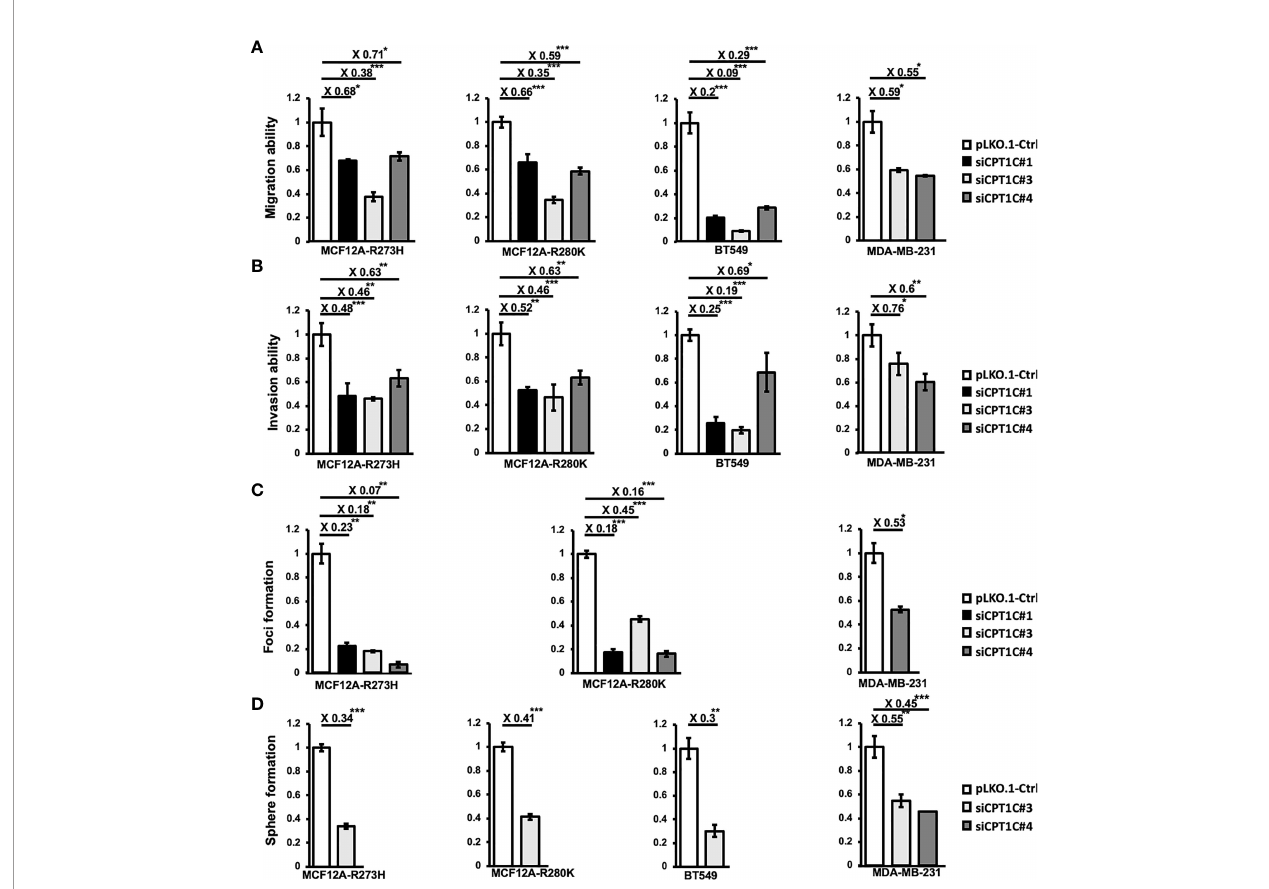
FIGURE 4 | Interference of CPT1C expression attenuates mutant p53-mediated biological effects. CPT1C expression was downregulated by RNA interference in mutant p53-overexpressing cells (MCF12A-p53 R273H and MCF12A-p53 R280K ) and BLBC cell lines (BT549 and MDA-MB-231), and these cell lines were then subjected to the following analysis. (A, B) Downregulating CPT1C expression attenuates migration and invasion ability in mutant p53-overexpressing mammary epithelial cells and BLBCs. The migration (A) and invasion (B) ability of CPT1C-KD cells (siPCK2 #1, #3, or #4) were analyzed by migration/invasion assay done in triplicate. The relative migration/invasion ability is presented as a fold change of the numbers of cells passed through trans-wells between control and CPT1C-KD cells (mean ± SD; n = 3). The two sides of the lines above the bars indicated the comparison of each KD clone to the control, and the value of fold changes with the asterisks representing signi fi cance was marked above the line. Data were analyzed by unpaired t-test. *p <0.05; ***p < 0.001. (C) Downregulating CPT1C expression diminishes the anchorage-independent growth in MDA-MB-231 and mutant p53-overexpressing mammary epithelial cells. The anchorage-independent growth ability of CPT1C-KD cells was examined by soft-agar foci formation assay (mean ± SD; n = 3). The two sides of the lines above the bars indicated the comparison of each KD clone to the control, and the value of fold changes with the asterisks representing signi fi cance was marked above the line. Data were analyzed by unpaired t-test. *p <0.05; **p <0.01; ***p < 0.001. (D) Interference of CPT1C expression suppresses stemness/cancer stemness in mutant p53-overexpressing mammary epithelial cells and BLBCs. The stem cell/cancer stem cell properties of CPT1C KD cells were examined by mammosphere forming assay (mean ± SD; n = 3). The two sides of the lines above the bars indicated the comparison of each KD clone to the control, and the value of fold changes with the asterisks representing signi fi cance was marked above the line. Data were analyzed by unpaired t-test. **p < 0.01; ***p <